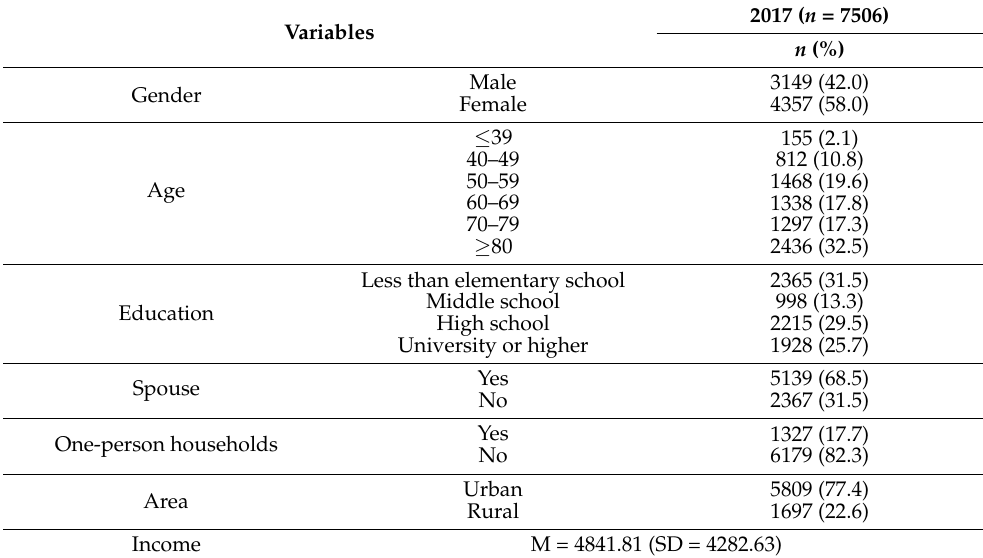
Table 1. Demographics of survey